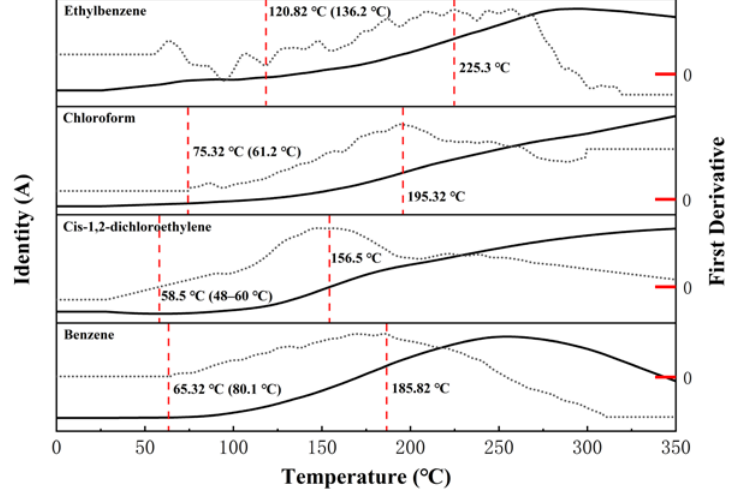
Figure 6. Ion current intensity curve of the main organic pollutants desorbed during the drying of the initial soil sample.